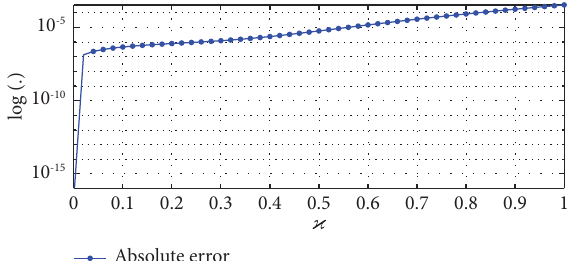
Figure 4: Absolute error values for m � 18 for Example 2.